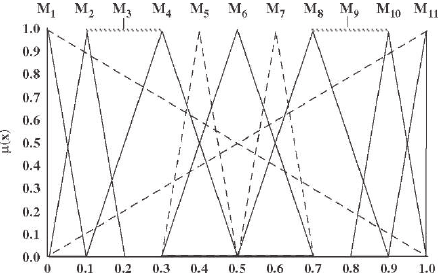
Fig. 1. Linguistic terms into their corresponding fuzzy Conversion of linguistic terms into fuzzy scores (11-point scale) Linguistic term Fuzzy no. Crisp no. Exceptionally low M 1 0.045 Extremely low M 2 0.135 Very low M 3 0.255 Low M 4 0.335 Below average M 5 0.410 Average M 6 0.500 Above average M 7 0.590 High M 8 0.665 Very high M 9 0.745 Extremely high M 10 0.865 Exceptionally high M 11